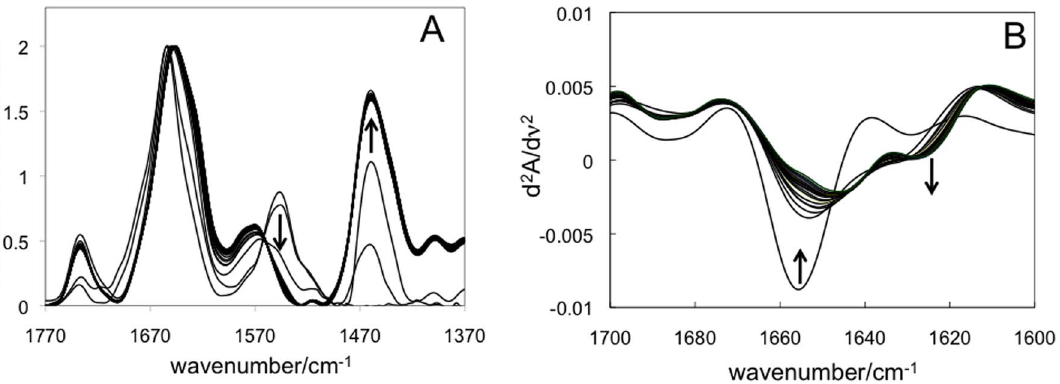
Figure 3. FTIR spectra of rArom during H/D exchange. A) Spectra recorded as a function of time after connecting the sample cell with a 2 H 2 O-saturated nitrogen flow. The spectra are normalized for the amide I signal. B) Second derivative spectra obtained from the FTIR spectra recorded as a function of time. The signals at 1655, 1623 and 1640 cm 2 1 are assigned to a -helices, b -sheets and random coil, respectively [49].